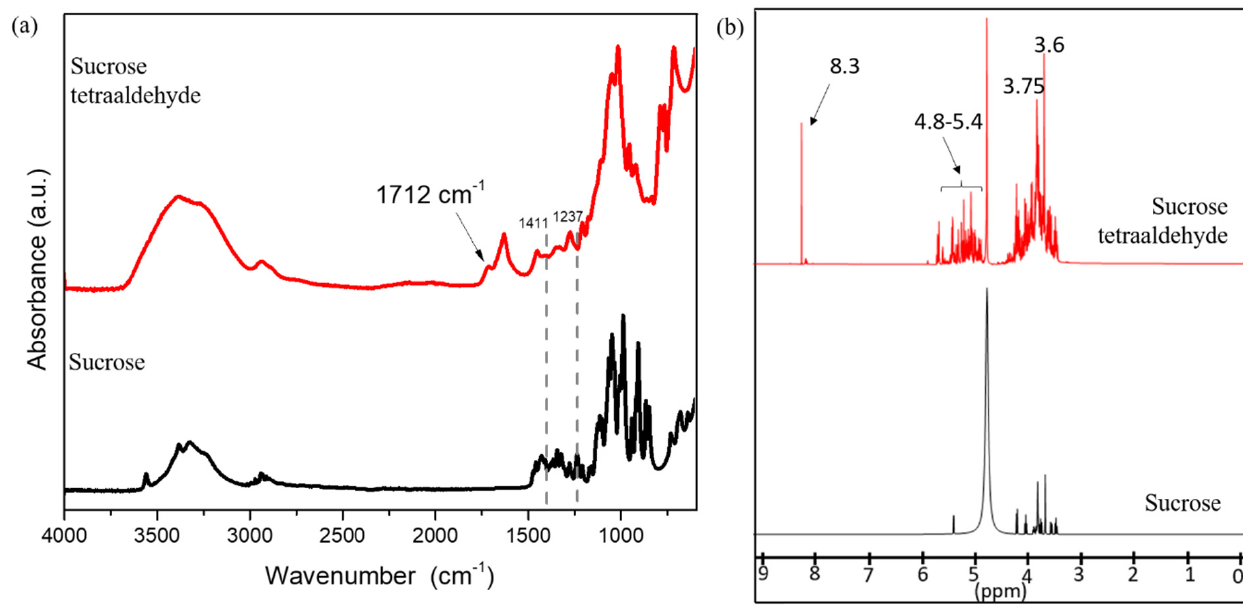
Figure 1. ( a ) ATR-FTIR and ( b ) 1 H-NMR spectra of sucrose and sucrose tetraaldehyde.